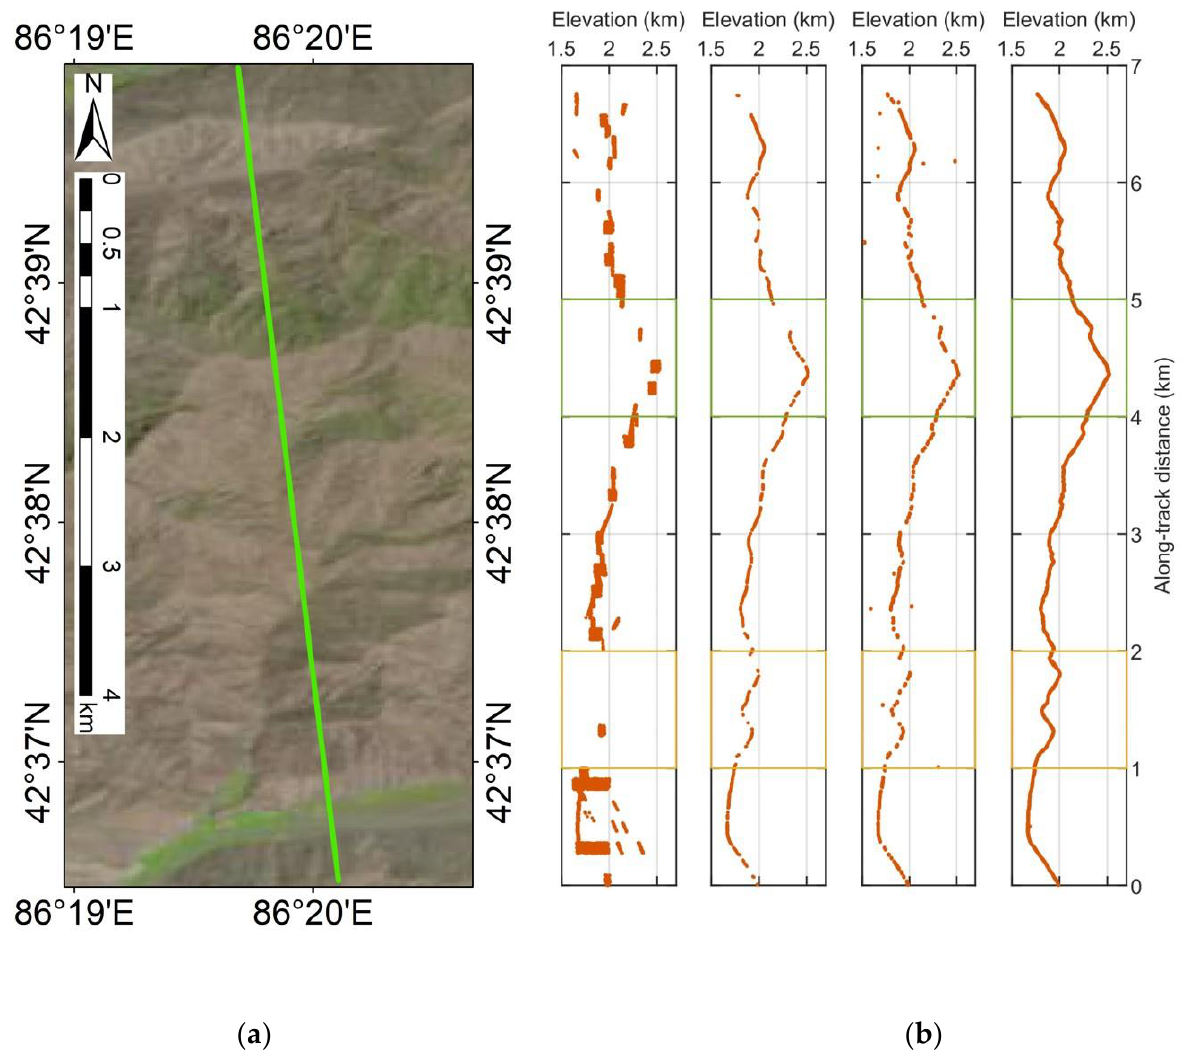
Figure A5. ( a ) ICESat-2 ATLAS ground track (a descending track) and satellite imagery in the Tian Shan Mountains. ( b ) The signal photons extracted by different methods. The diameter and threshold of the classical DBSCAN were set as 6.5 m and 7, respectively. Two sampled segments within the yellow and green boxes were enlarged and illustrated in Figure A6a,b to show the details, respectively.